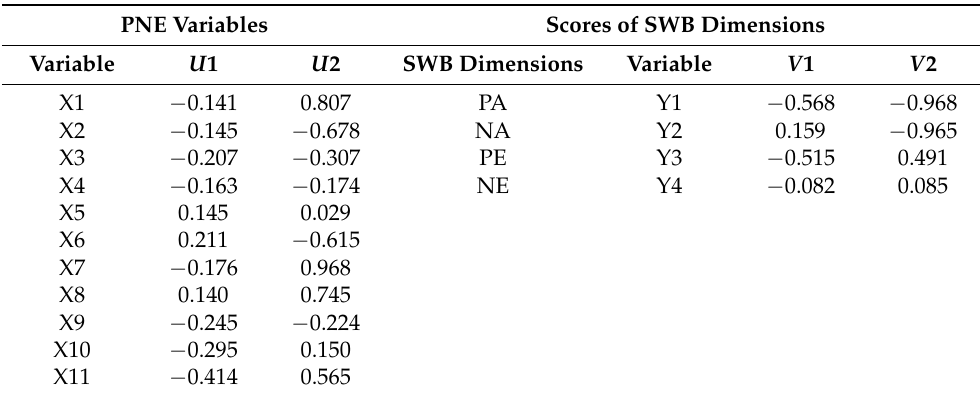
Table 5. The correlation coefficients between the scores of the subjective wellbeing dimensions and perceived neighbourhood environment variables.